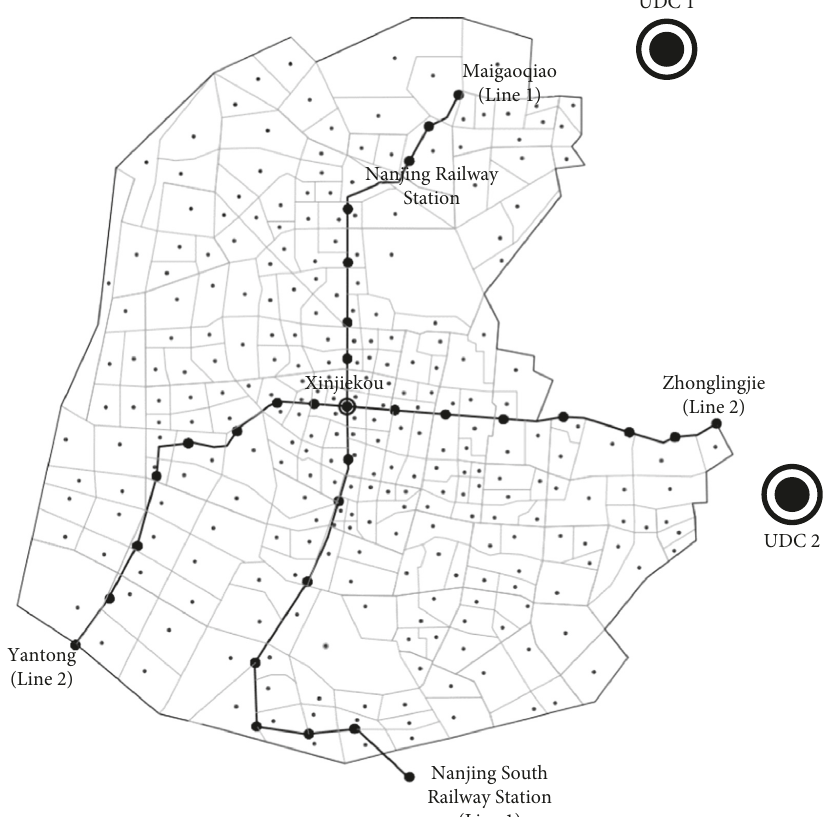
Figure 4: Sketch map of metro lines and demand